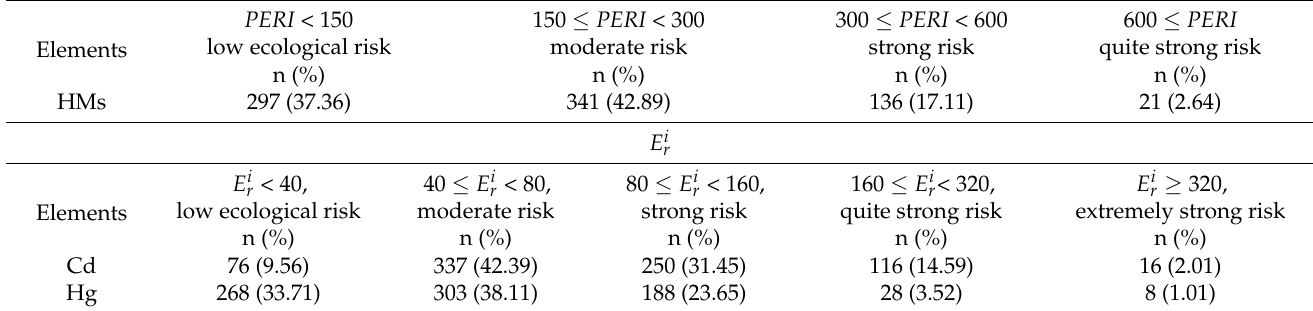
Table 5. Assessment on potential ecological risk of heavy metals in the study area.